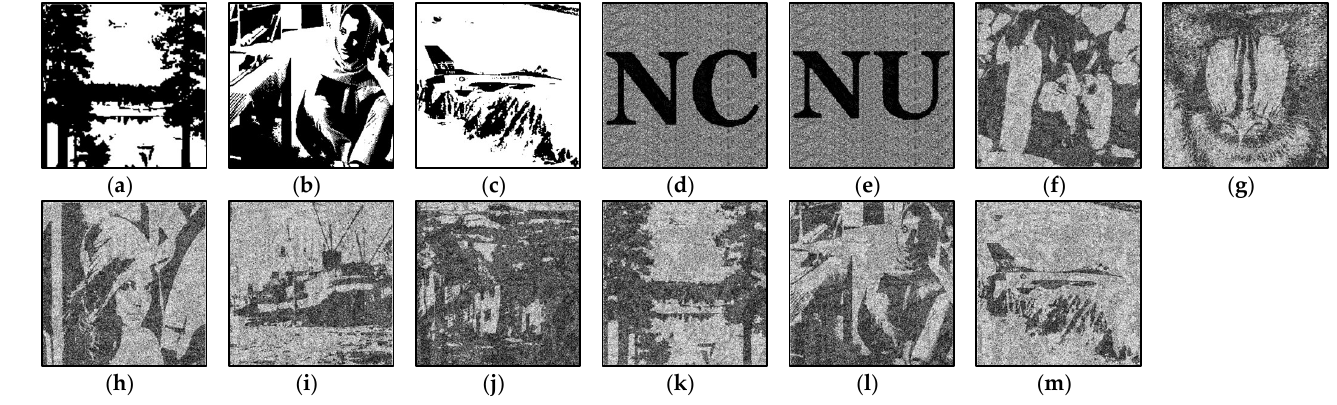
Figure 13. Experimental results by Method 4 for (8, 8) with 𝑝 = 10, 𝛾 = 0.5 . ( a – c ) Camouflage images D 5 , D 6 , D 7 , ( d , e ) Restored images R 0 , R 1 ( f )–( m ) Shares M 0 , …, M 7 .